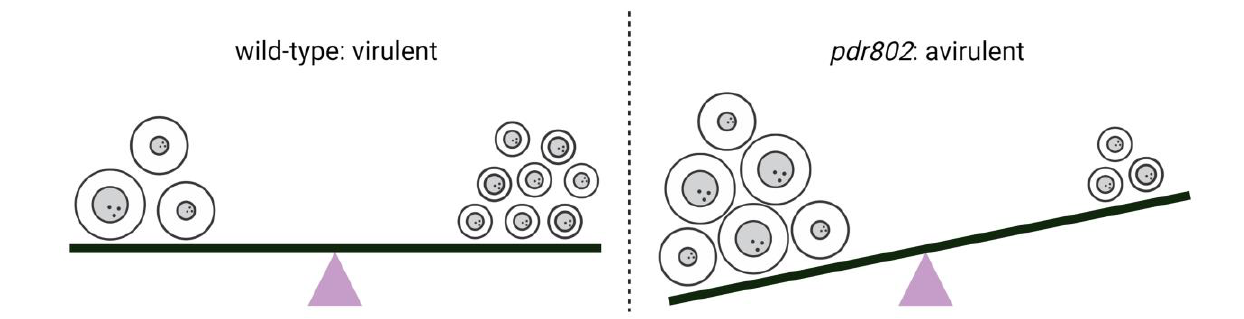
FIGURE 2: Effective pathogenesis requires tight regulation of virulence factors. Optimum levels of capsule thickness and Titan cell formation are key to the success of wild-type infection (left); perturbation of this balance greatly reduces the pathogenicity of the pdr802 mutant strain